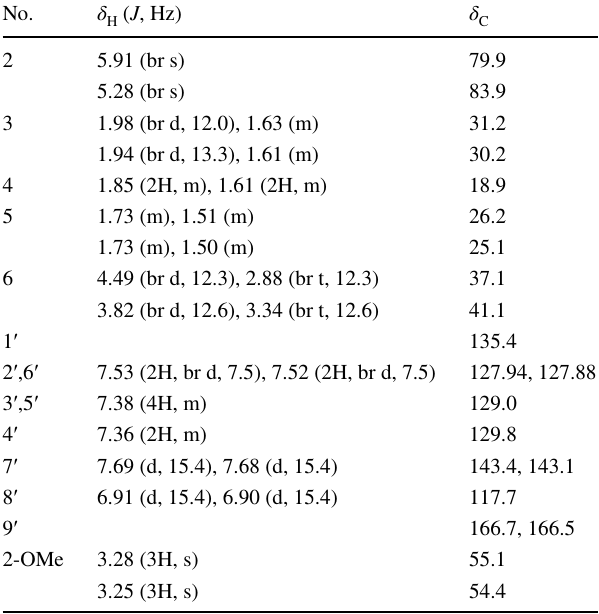
Table 1 1 H (800 MHz) and 13 C NMR (201 MHz) data of 1 in CDCl